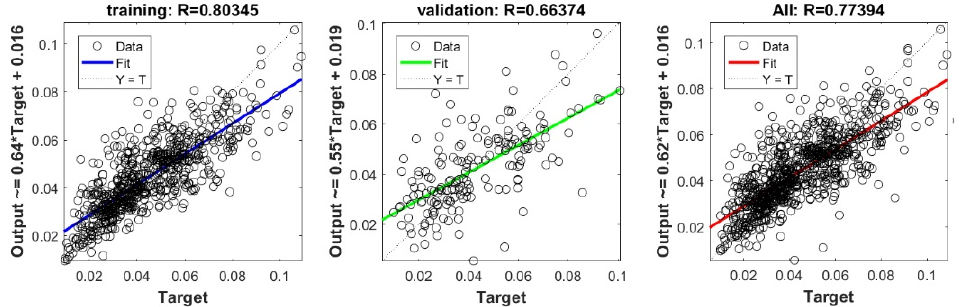
Figure A11. Scatter plots between target and output value by the GT-DNN model.